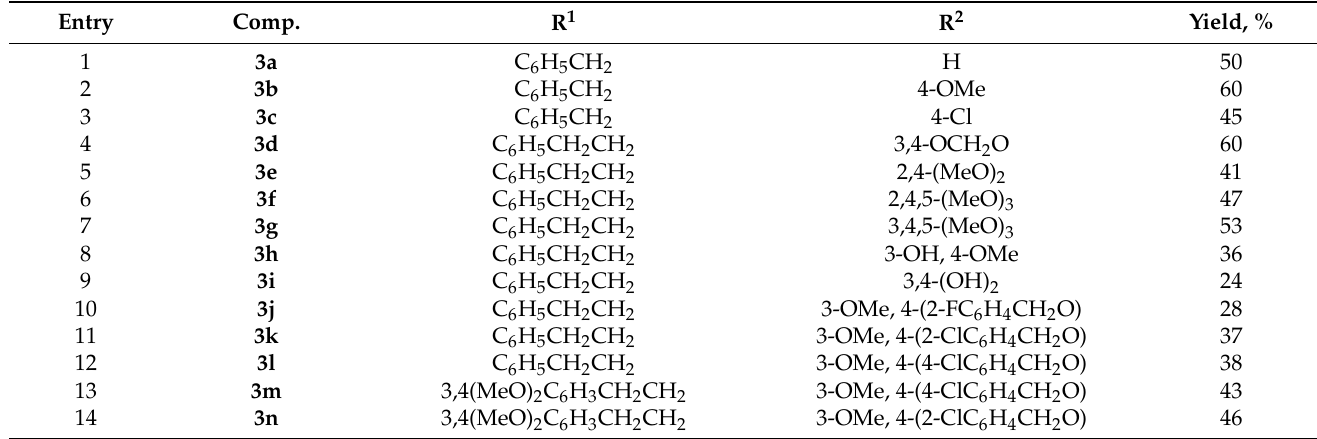
Table 1. Structures and yields of compounds 3a – n